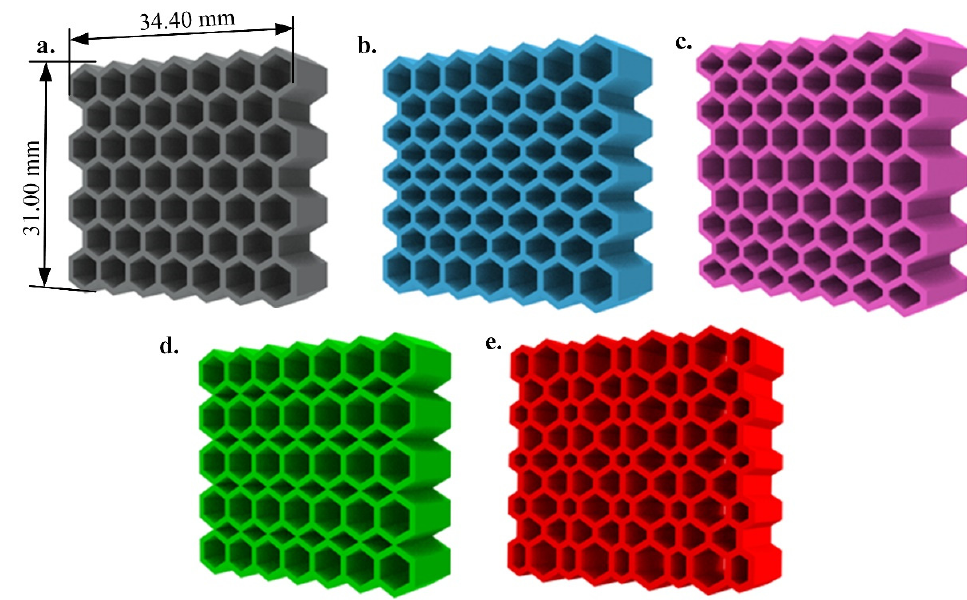
Figure 1. Geometrical drawing of the samples 1 to 5 ( a – e ).